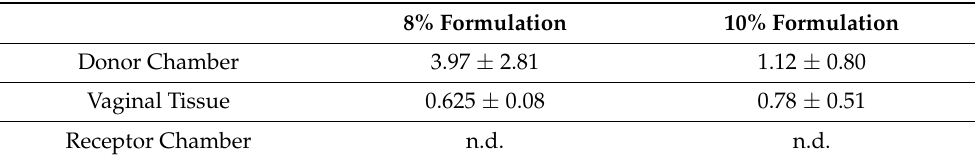
Table 2. C 8 concentrations (ng/mL) present in the different compartments after the permeation study on porcine vaginal tissue (24 h in Franz cells) after treatment with formulation containing AS1411-AuNPs with C 8 . The results represent the mean and standard deviation of 3 tissue Franz cell experiments. n.d.—the compound was not observed in the proper retention time in the HPLC- FLD